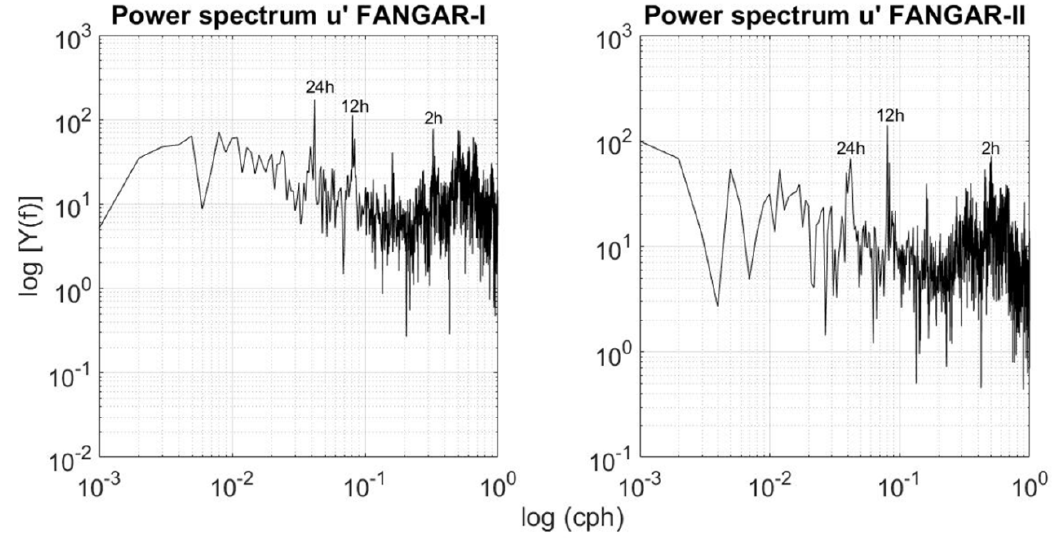
Figure 7. Spectral analysis of the signal of the alongshore current in the mouth for FANGAR-I ( left ) and FANGAR-II ( right ).